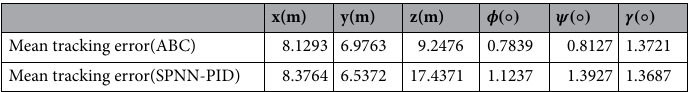
Table 3. The comparison for control statistical indicators of task